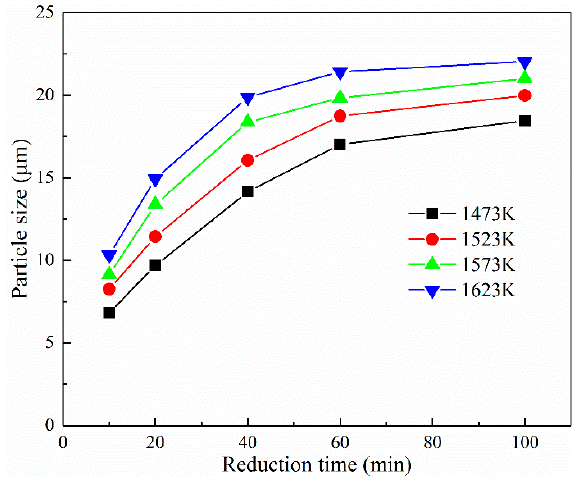
Figure 11. Effect of temperature and time on the average particle size of iron grain.